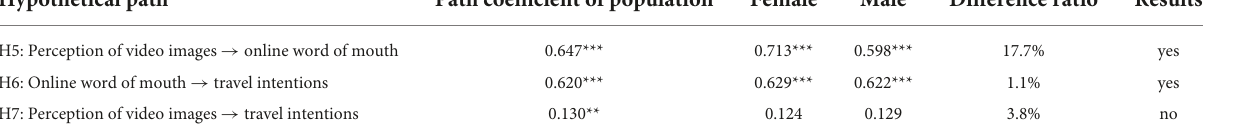
TABLE 7 Moderating effect test for